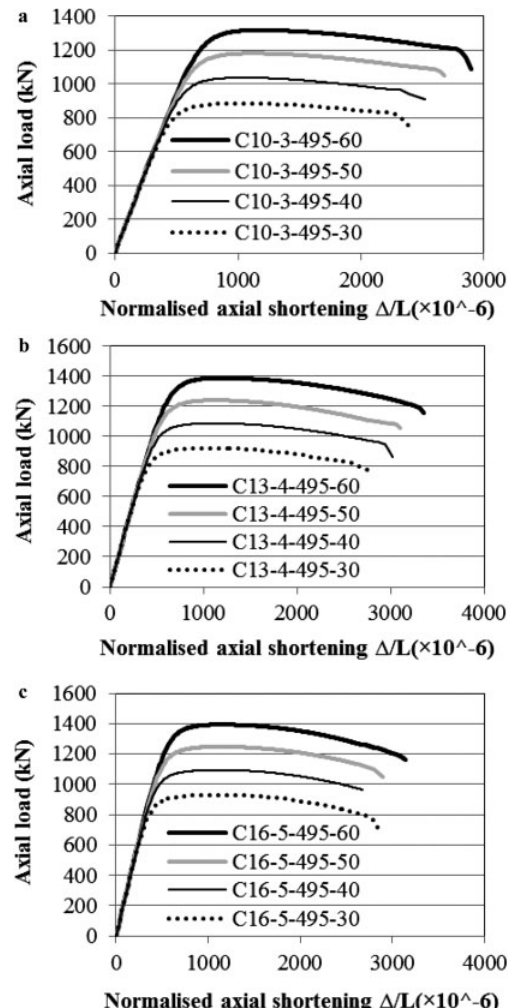
Fig. 9. Effect of concrete compressive strength on ultimate axial load capacity ( t (cid:4) 4 mm): (a) u (cid:4) 1.65 8 , (b) u (cid:4) 2.20 8 , (c) u (cid:4) 2.75